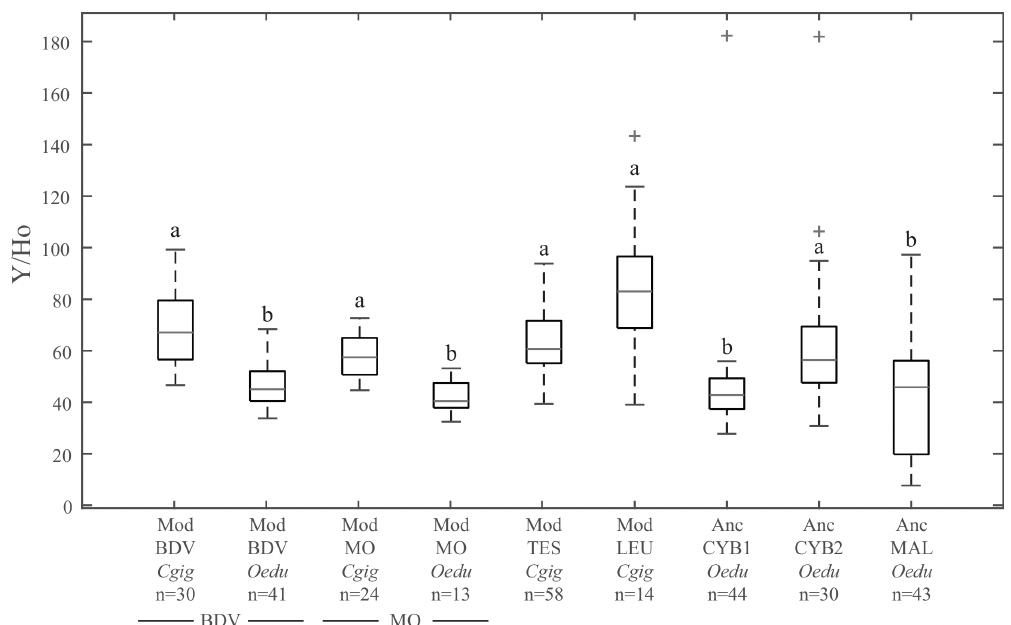
Figure 3. Box plots of Y / Ho ratios for all groups. The letters on top of the boxes ( a and b ) identify the significant differences between groups from Kruskal–Wallis tests. Note that for the same locality at Baie des Veys (BDV) and Marennes–Oléron (MO), the Y / Ho ratios are significantly different depending on the species considered ( C. gigas and O. edulis groups). Grey bars represent median values; the lower and higher large black bars represent the 25th and 75th percentiles, respectively, and the lower and higher small black bars represent the minimum and maximum values not considered outliers, respectively. Outliers are represented by grey